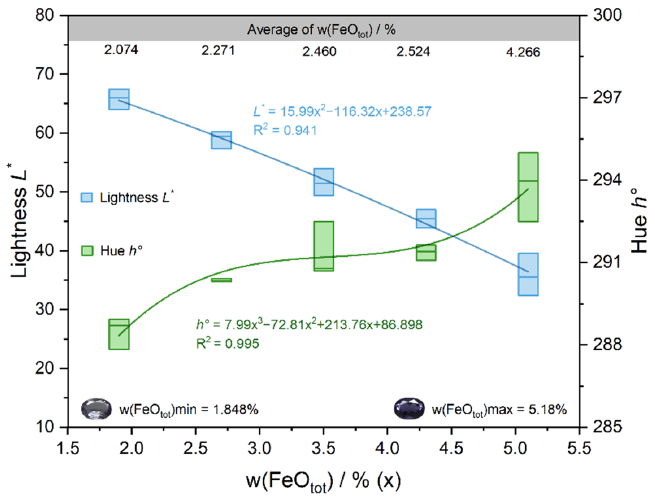
Figure 7. Relationship between w(FeO tot ) and color